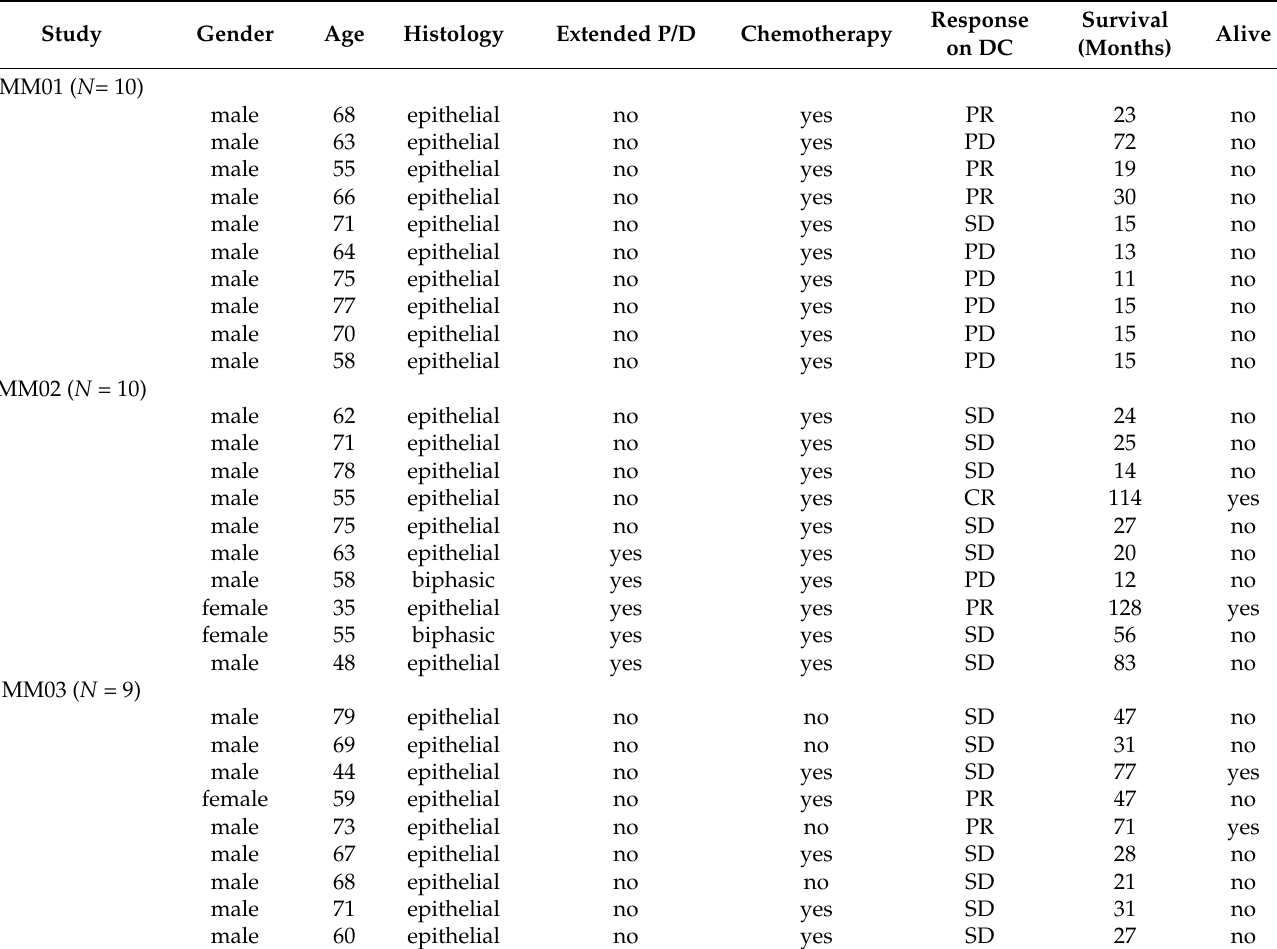
Table 1. Patient